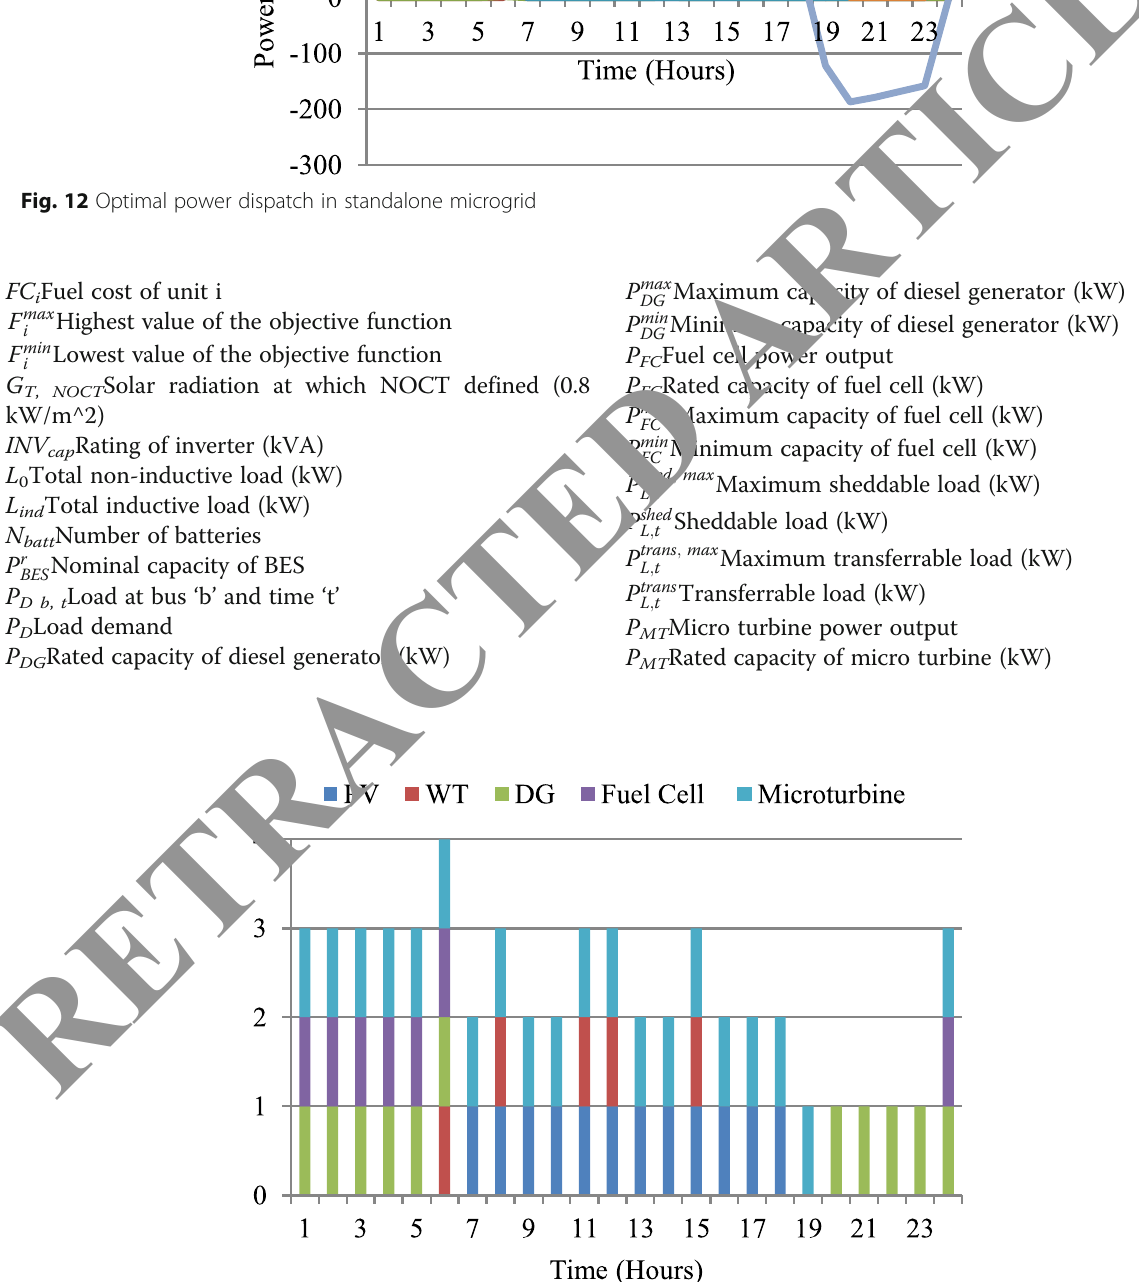
Fig. 13 Scheduling of hybrid energy in standalone